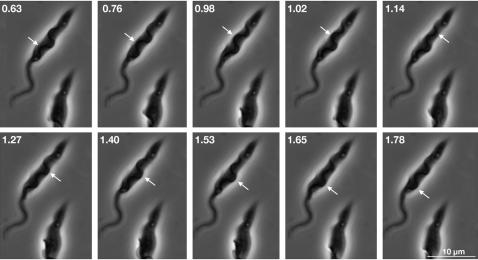
The new flagellum displays both tip-to-base and base-to-tip movements.Still images of Movie S2 (Supp. Mat.). Numbers indicate time in seconds and hundredths of seconds. Arrows indicate propagation of one wave bend (from tip to base on the first 4 images, from base to tip for the other ones).